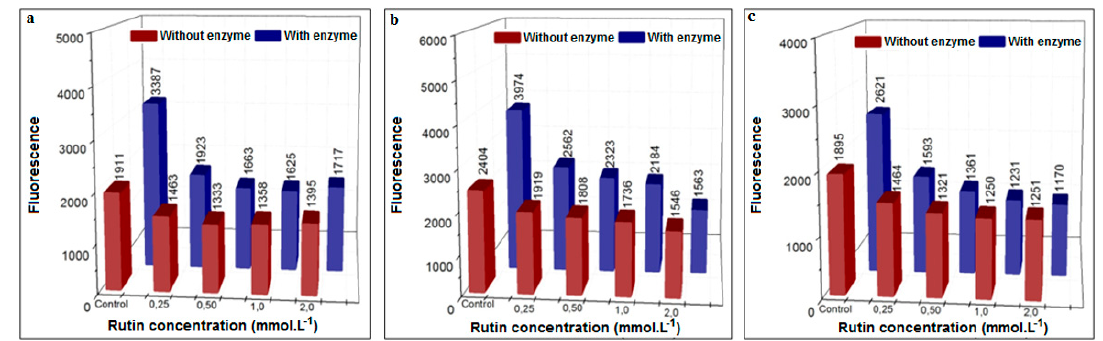
Figure 11. Inhibition of AGEs formation using different concentrations of rutin (37 °C) in the presence or absence of XO in pure phosphate buffer (pH = 6.6). ( a ) Procedure with glucose, 48 h incubation; ( b ) procedure with MGO, 3 h incubation; ( c ) procedure with GO, 3 h